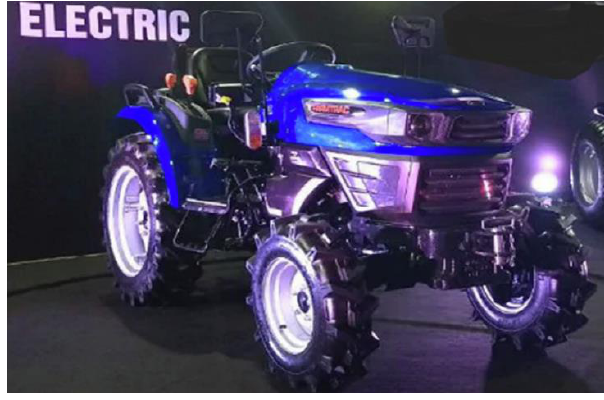
Fig. 26. Escorts Farmtrac 26E